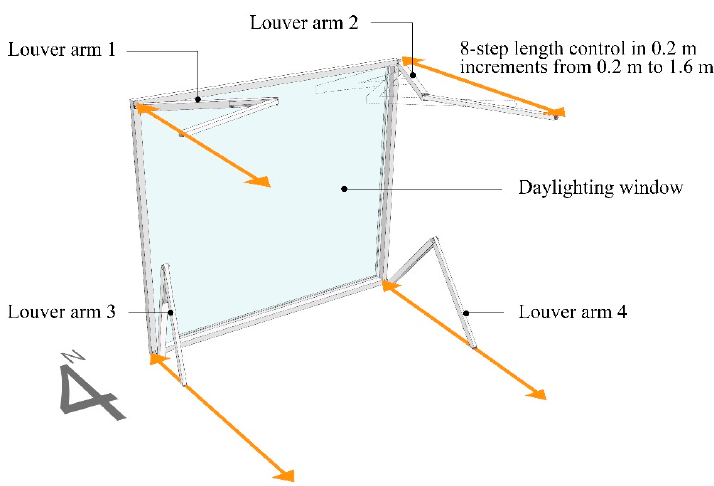
Figure 8. Louver arm control of the solar tracking-based movable louver (STML) .